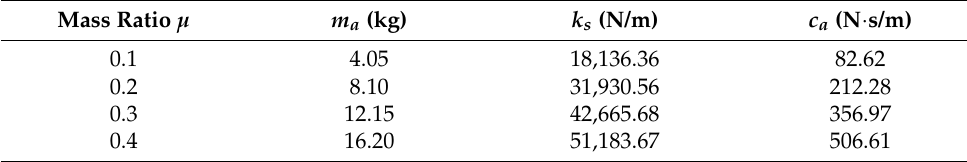
Table 2. Optimization parameters of H 2 with different mass